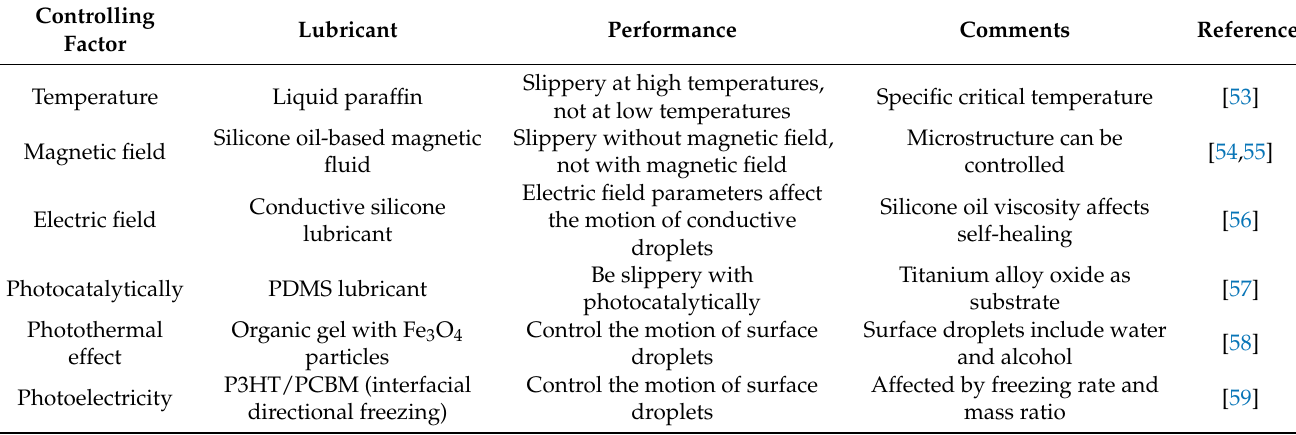
Table 4. Controllable slippery surfaces.